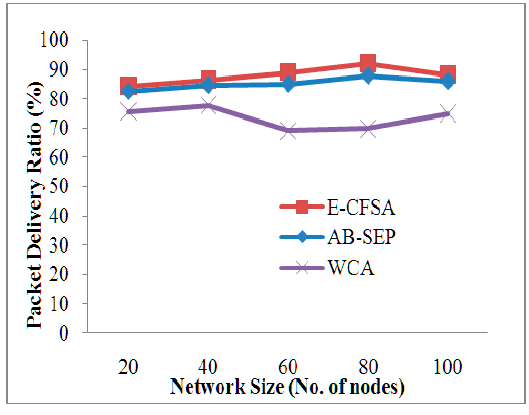
Figure 10. Graph PDR Vs. Network size.